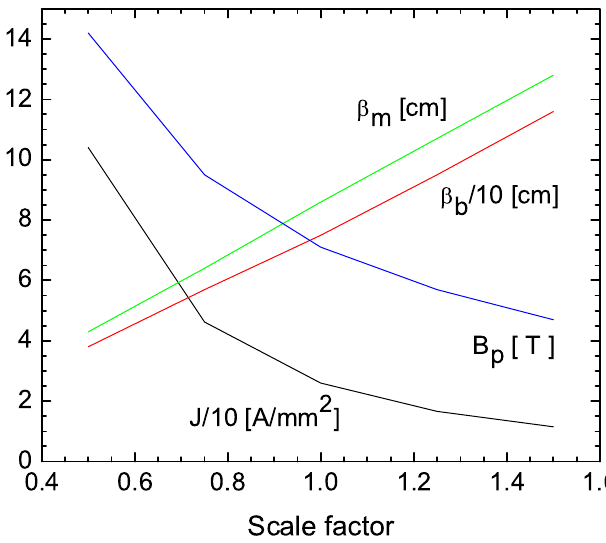
FIG. 18. (Color) Geometrical scaling of the A4 example lattice.